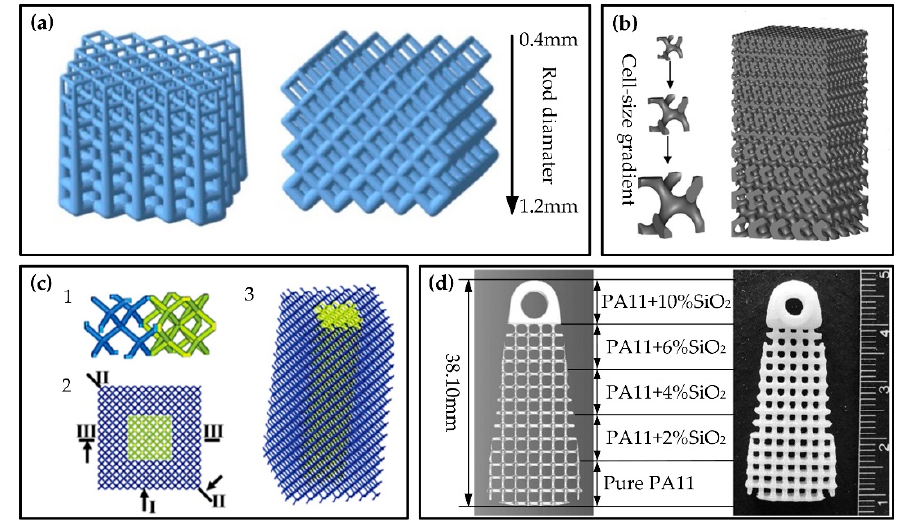
Figure 8. Common gradient structure design: ( a ) gradient structure formed by rod diameter variation, reproduced from [123], with copyright permission from Elsevier, 2017; ( b ) gradient structure formed by unit cell size change, reproduced from [124], with copyright permission from Elsevier, 2018; ( c ) gradient structure formed by three different unit cell structures: 1. two types of composition unit cell; 2. top view of the overall structure; 3 overall three-dimensional structure schematic, reproduced from [125], with copyright permission from John Wiley and Sons, 2015. ( d ) The gradient structure of the rotator cuff formed by different material components, reproduced from [126], with copyright permission from Elsevier, 2008.